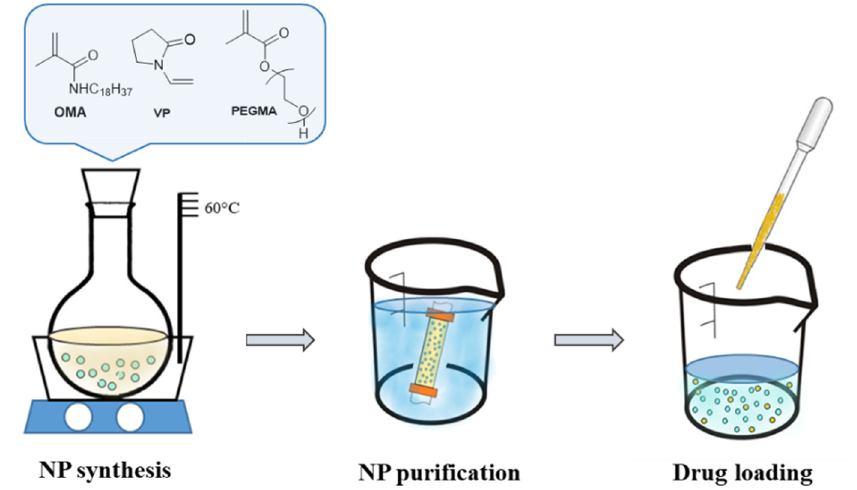
Figure 6. Schematic drawing of NP synthesis and